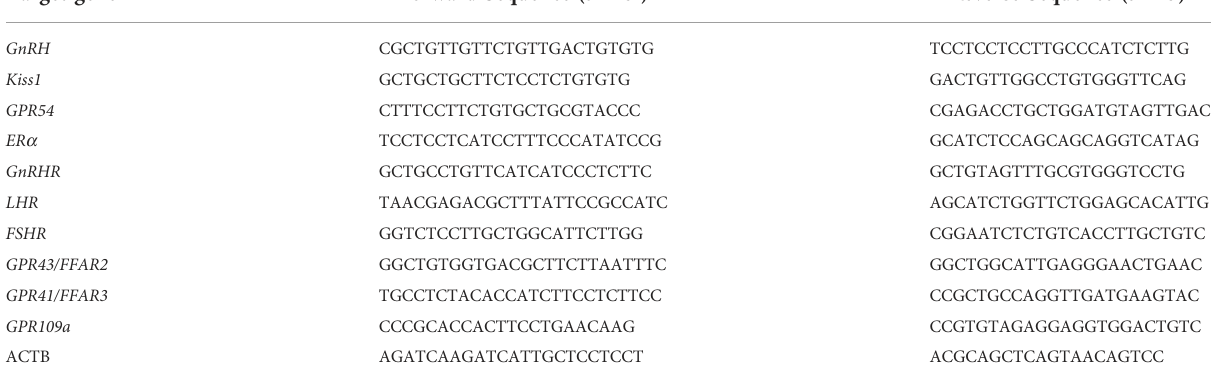
TABLE 1 Primers used for qPCR analyses. Target